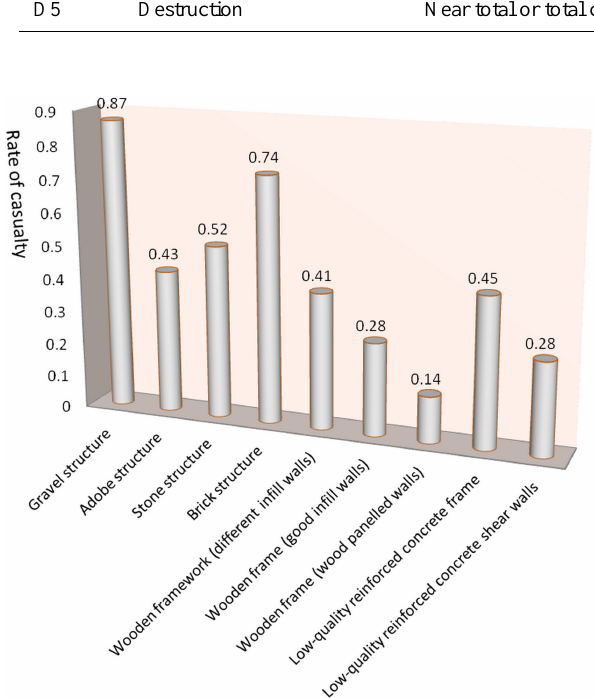
Figure 6. Death rate in collapsed buildings by different materials.